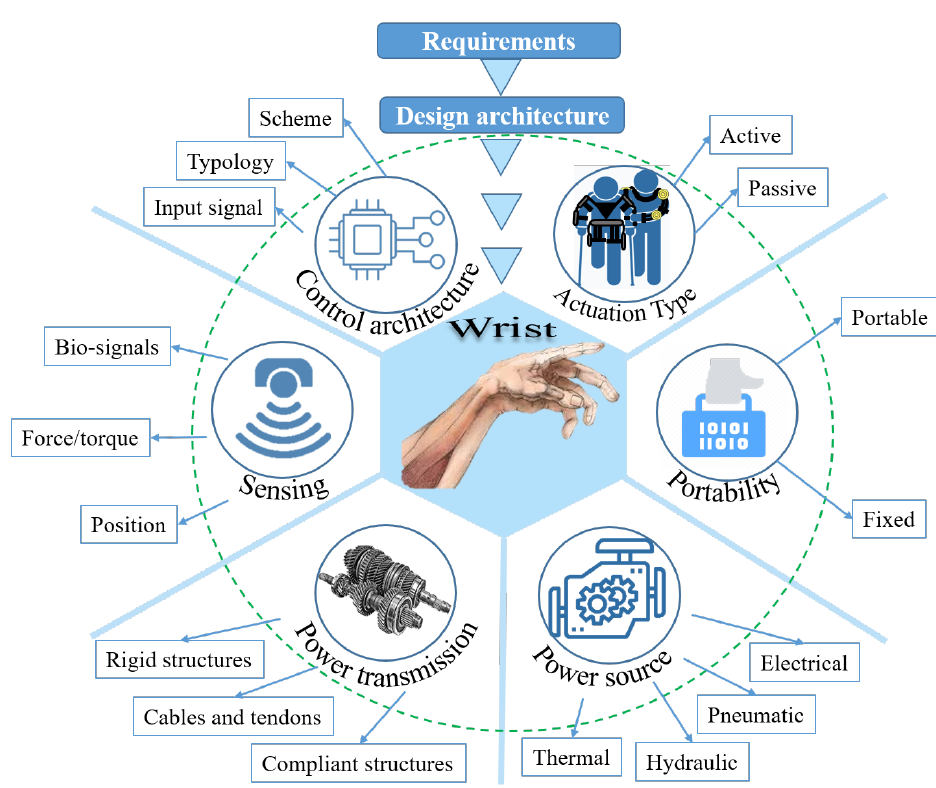
Figure 18. Classification criteria based on the design architecture of exoskeleton devices for wrist support.